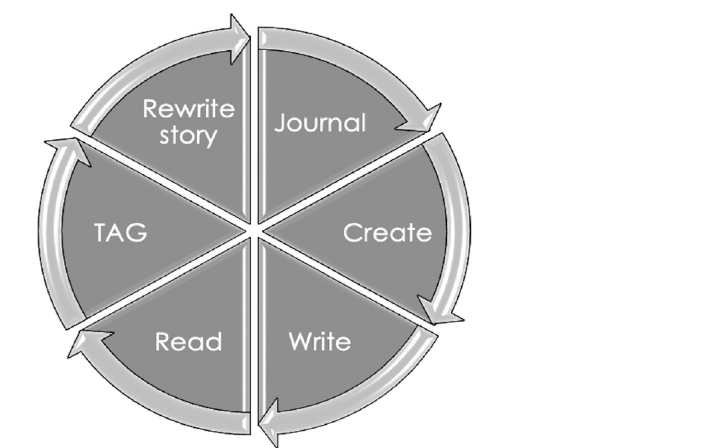
Figure 1. Psychosocial peace-building education course (Martin et al. ,